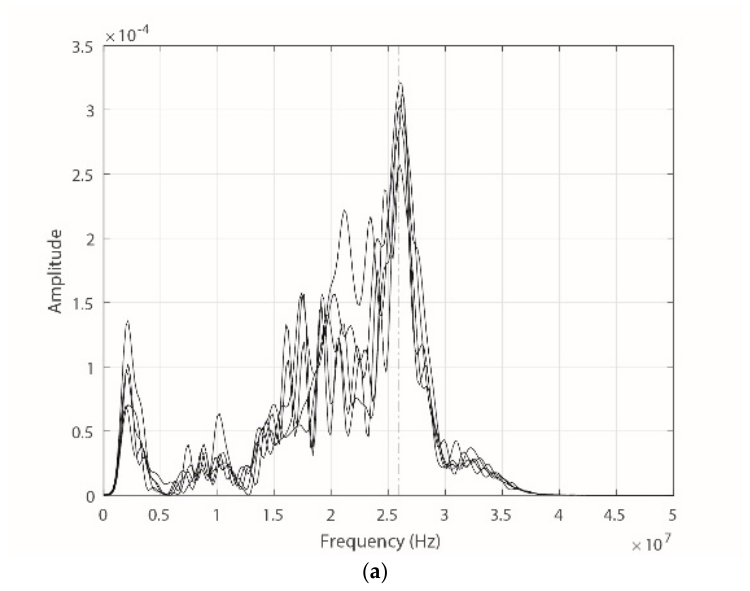
Figure 15. Comparison of the results obtained with the corona PD pulses for a values of 2 mm and 5 mm.